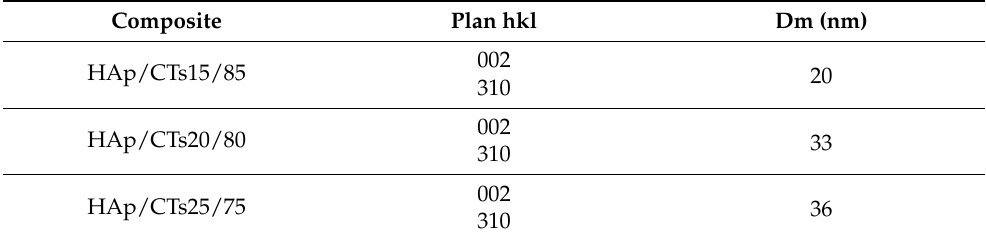
Table 1. The average size of HAp/CTs apatitic nanoparticles based on Scherrer’s formula.